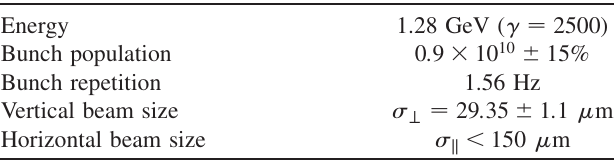
TABLE I. Beam parameters near the